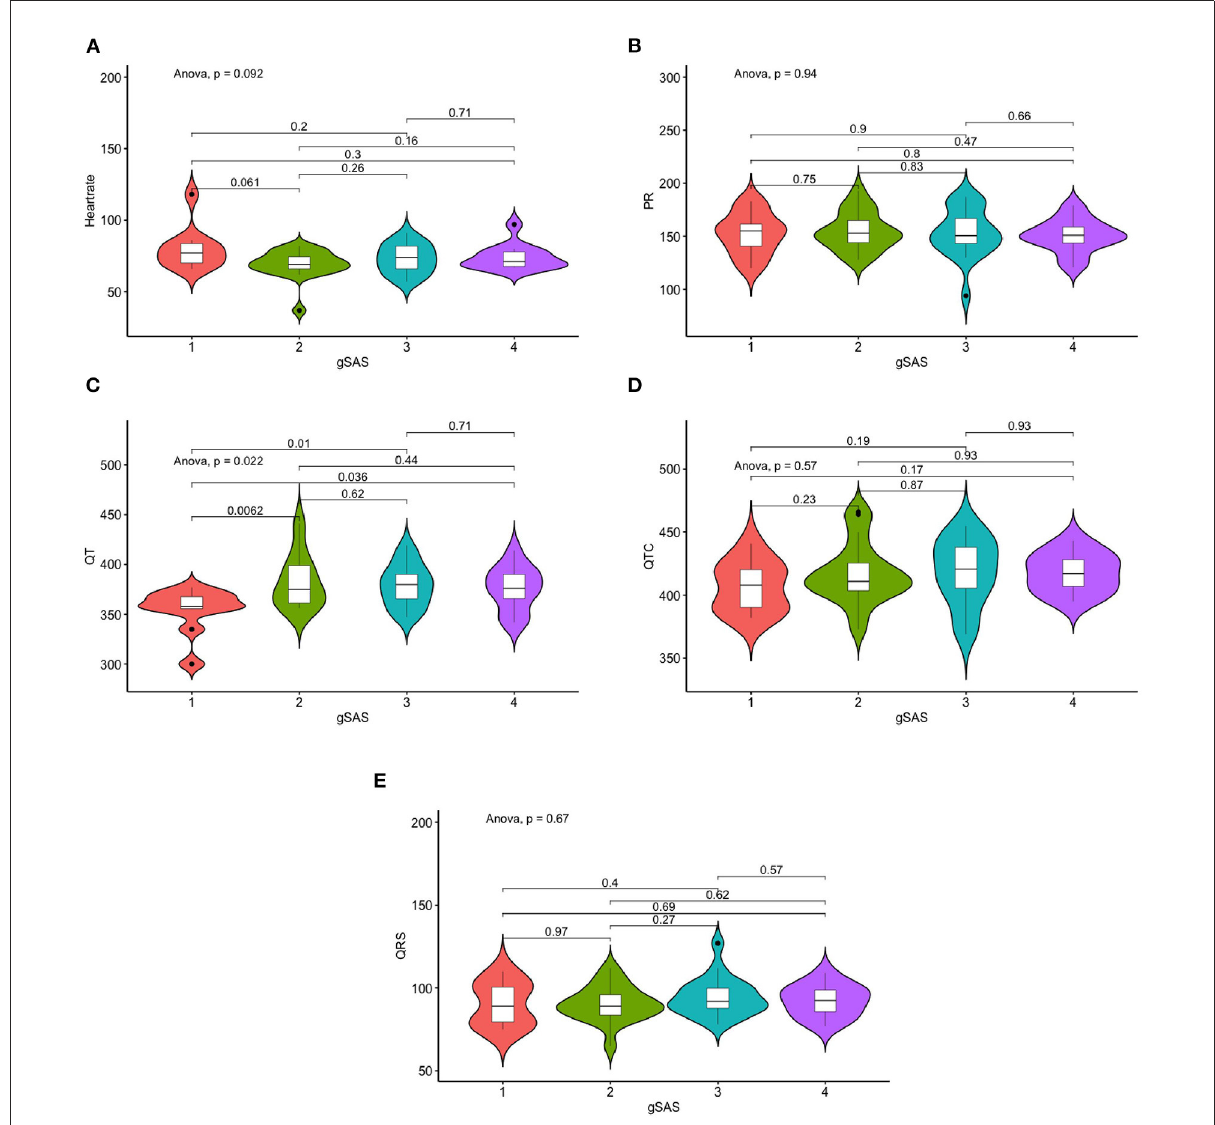
FIGURE3 Differences in ECG measures of anxiety severity. (A) Differences in Heart rate of anxiety severity. (B) Differences in PR of depression severity. (C) Differences in QT of depression severity. (D) Differences in QTC of depression severity. (E) Differences in QRS measures of depression severity.